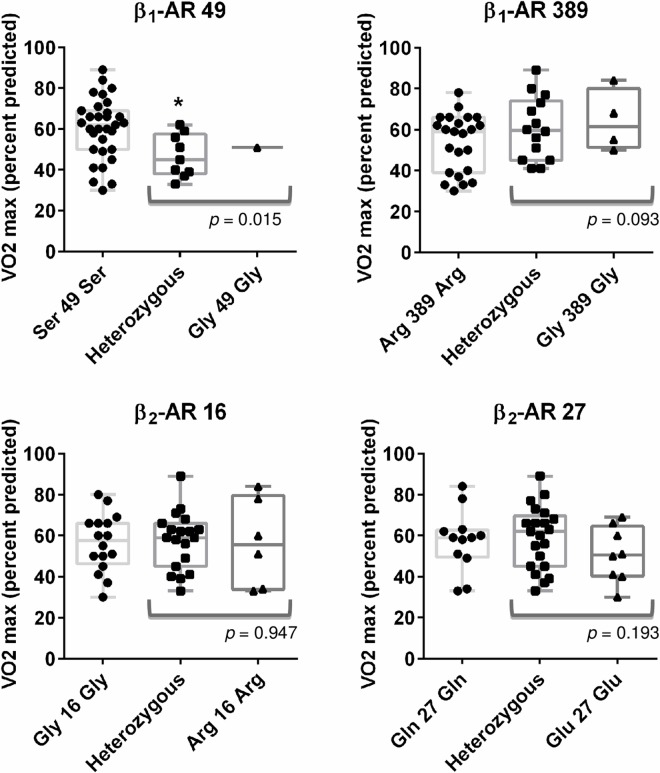
β1-AR and β2-AR SNPs and maximal exercise capacity.Peak VO2 is shown for β1-AR codon 49 and 389, β2-AR codon 16 and 27. Box graphs represent median, upper/lower quartiles and maximum/minimum values. *indicates a statistically significant difference (p <0.05) between SNP and peak VO2. Figures represent box plot for each genotype combination (homozygous for the major allele, WT/WT, heterozygous WT/minor allele and homozygous for minor allele).